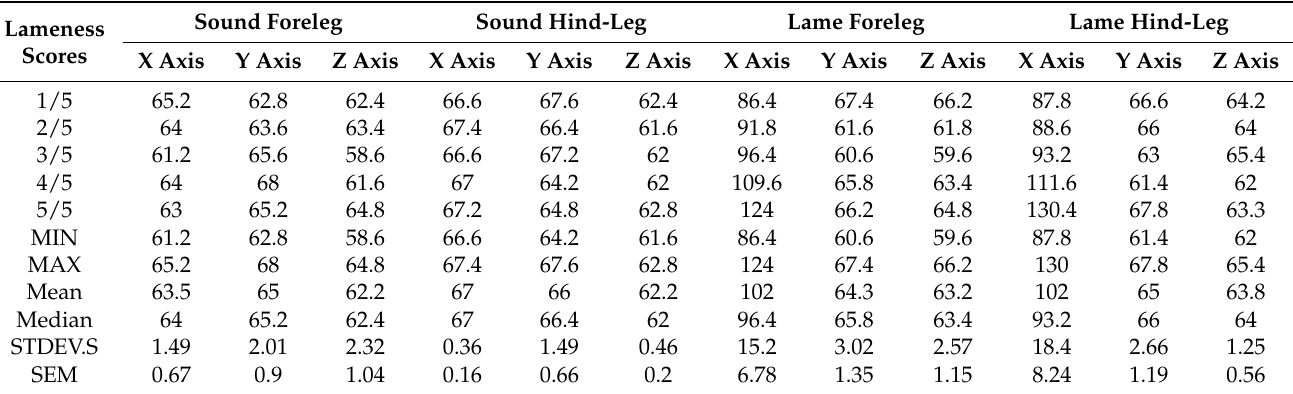
Table 2. Descriptive statistics of the mean impulse values recorded by the Lameness Detector 0.1 in the studied horses ( n =